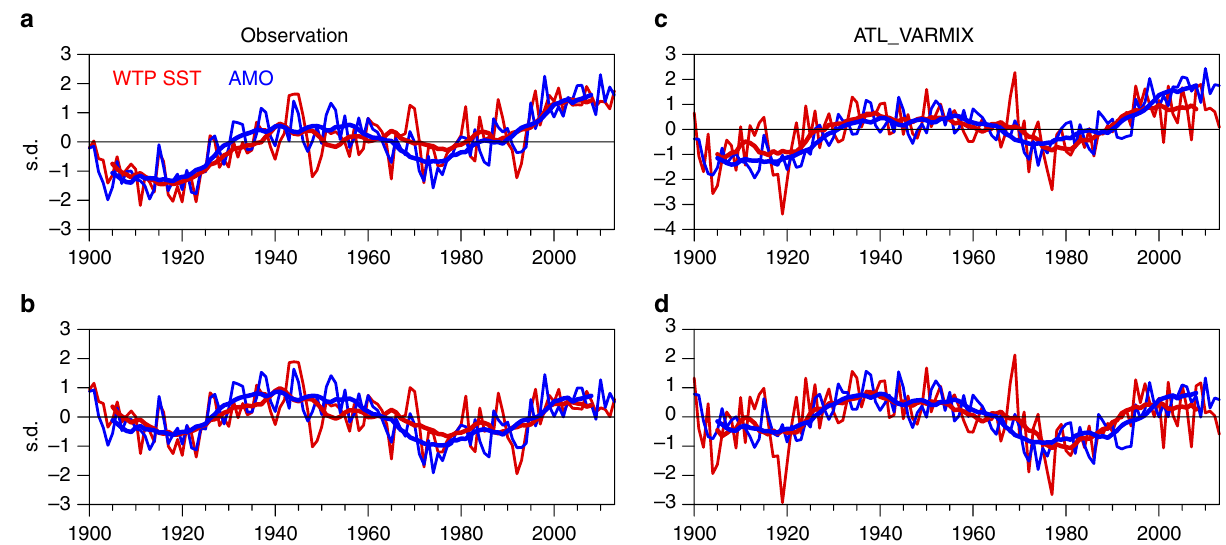
Figure 1 | The Atlantic–western tropical Pacific SSTconnection in the observations and ATL_VARMIX simulations. ( a ) Time series of the western tropical Pacific SSTand Atlantic multidecadal oscillation indices for the period 1900–2013 (thin lines) and 11-year running averages (thick lines), normalized by the long-term s.d. ( b ) As in a , but for the time series after removing the long-term linear trend. ( c , d ) As in a and b but based on the data from the ATL_VARMIX simulations.